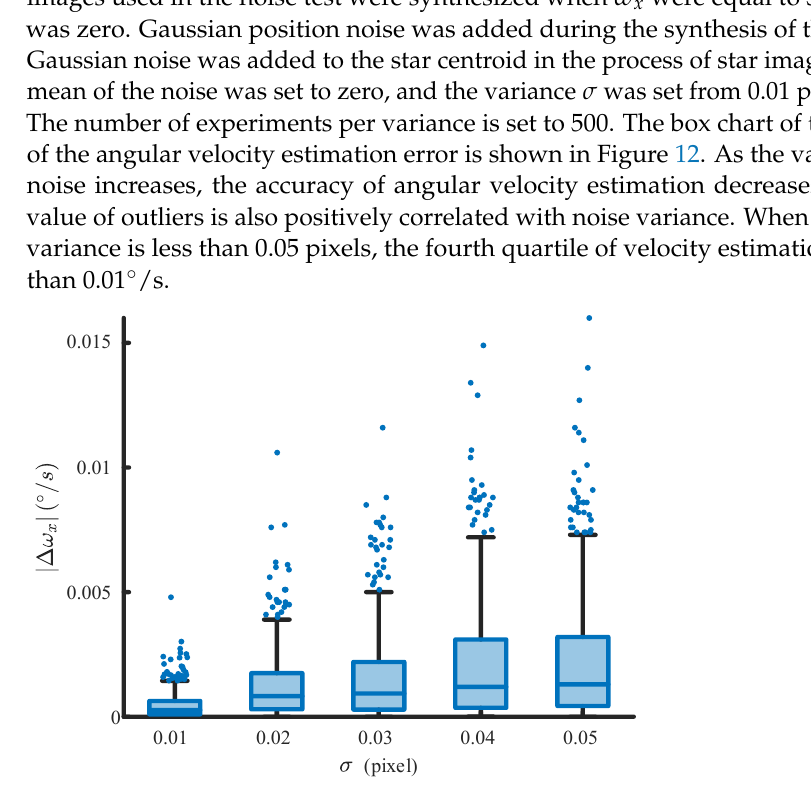
Figure 12. Absolute value of the angular velocity estimation error under noise variance.